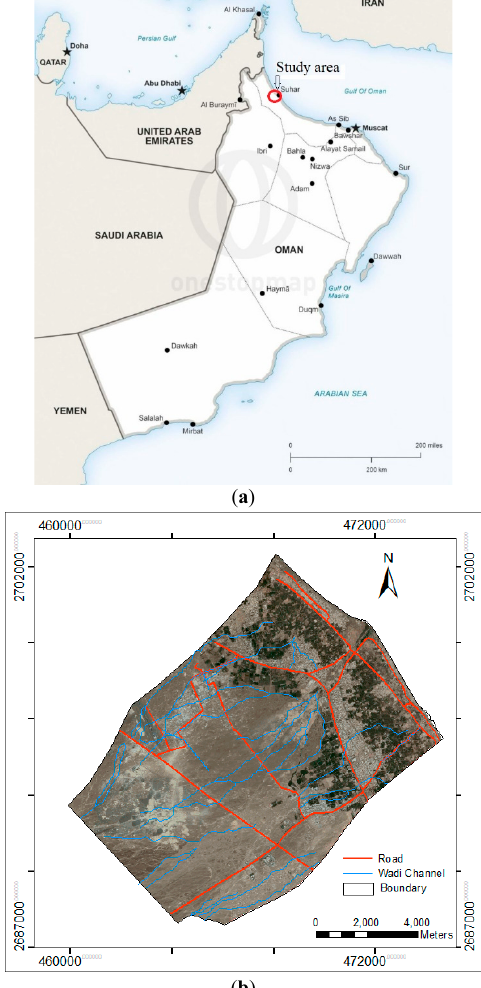
Figure 1. ( a ) Map of the Sultanate of Oman (onestopmap.com, accessed on Nov. 12, 2022) with a red circle near Suhar showing the location of the study area. ( b ) Part of the Wadi Al-Jizi aquifer, which is the computational domain .